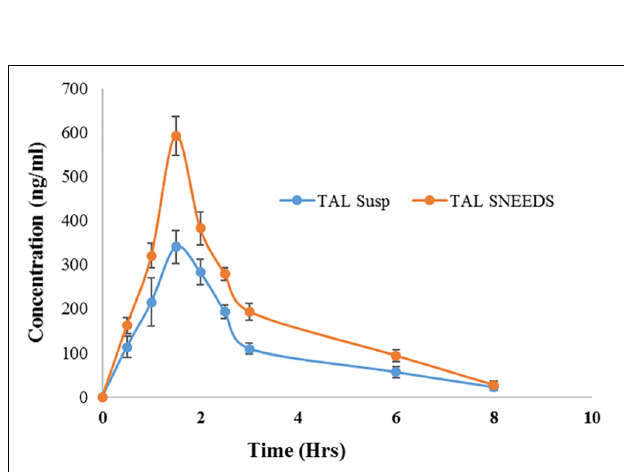
FIGURE 10 | Plasma concentration– time profiles of TAL after a single oral administration of SNEDDS formulation [I308: TC (1:1)/HCO-30 (1/1)] and TAL powder to rats at a dose equivalent to 10 mg/kg TAL (mean ± SEM, n = 6).